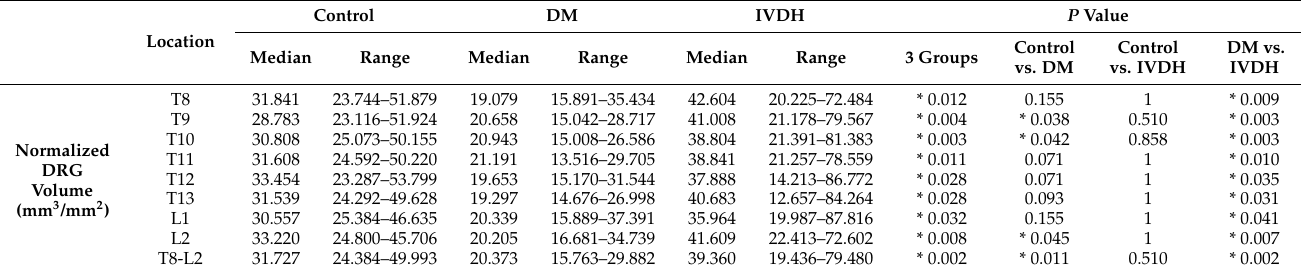
Abbreviations: DRG, dorsal root ganglion; DM degenerative myelopathy; IVDH, intervertebral disc herniation. * P <